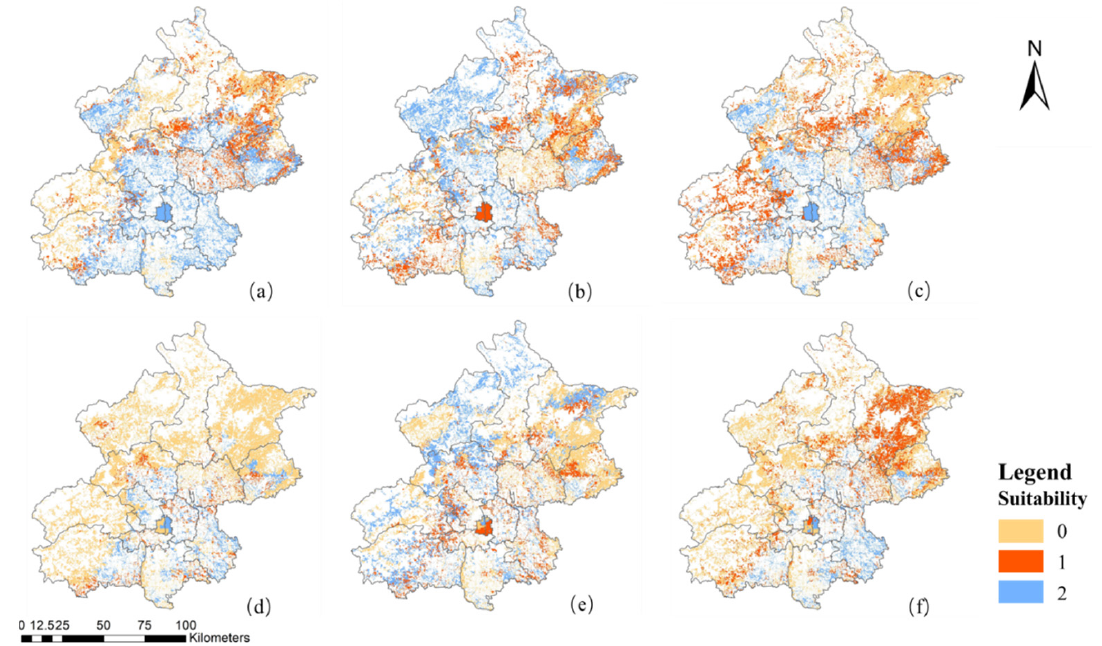
Figure 6. Predicted suitable areas for six main tree species in Beijing. In the legend, 0 means unsuitable, 1 means suitable, and 2 means the most suitable. ( a ) Platycladus orientalis (Linn.) Franco; ( b ) Pinus tabulaeformis Carr.; ( c ) Robinia pseudoacacia Linn.; ( d ) Sophora japonica Linn.; ( e ) Salix matsudana Koidz.; ( f ) Populus tomentosa Carr.